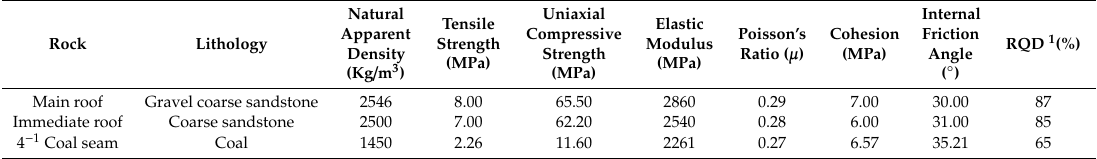
Figure 5. Geological map of coal seam in Bailu Coal Mine. Table 1. The physical and mechanical parameters of